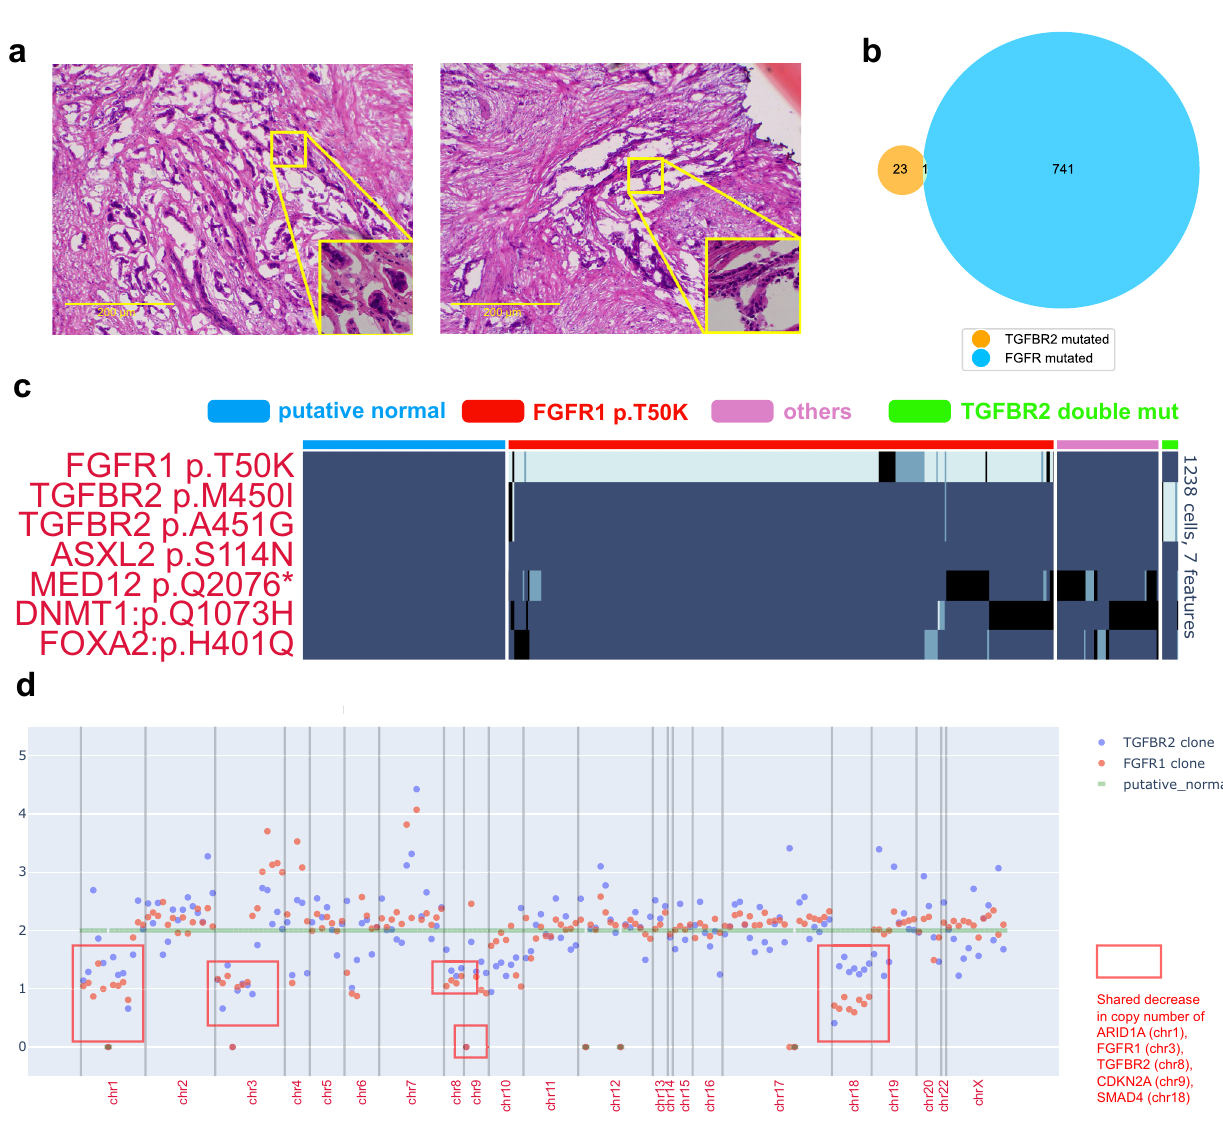
Fig. 5 | SnDNA-seq identi fi ed two mutually exclusive SNV clones in a PDAC patient without KRAS mutation.a Representative H&Ehistology images of PDAC regions in samples PR01-1 (left, only the TGFBR2 double mutation was present), PR01-2 (right, only the FGFR1 mutation was present). At least 2 representative pictures were taken per sample and yielded similar results. b For sample PR01-3 (both the TGFBR2 double mutation and FGFR1 mutation were present), Venn dia- gramshowingsingle-cellcolocalizationpatternofthe TGFBR2 doublemutationand FGFR1 mutation. c Single-cell genotype (HOM homozygous mutation, HET het- erozygous mutation, WT wildtype) heatmap of 7 important variants pre-identi fi ed